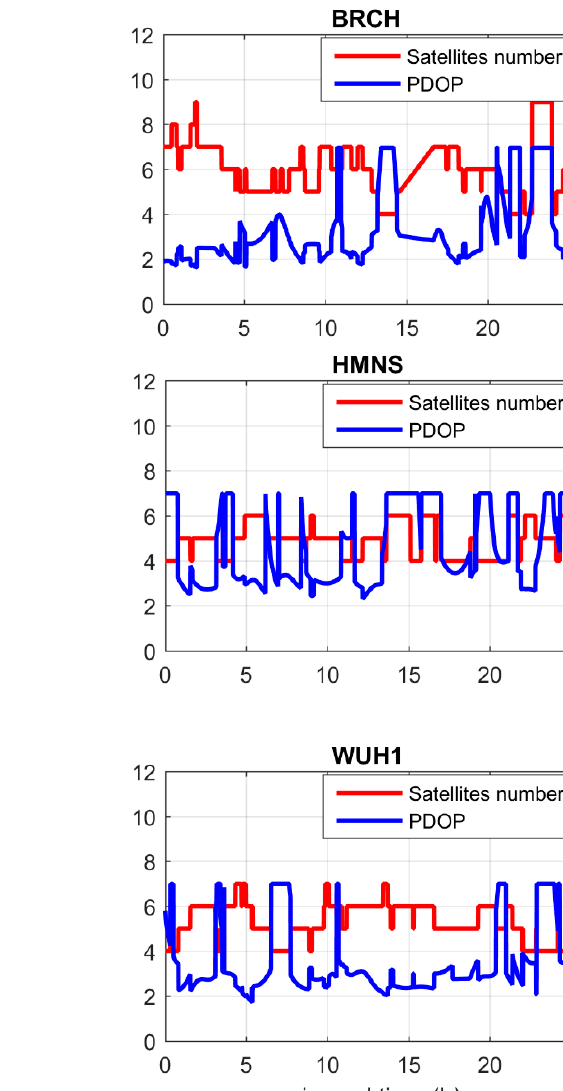
Figure 13. Pseudorange residual scatters of B1I, B3I, B1C and B2a SPP with different schemes at BRCH station.